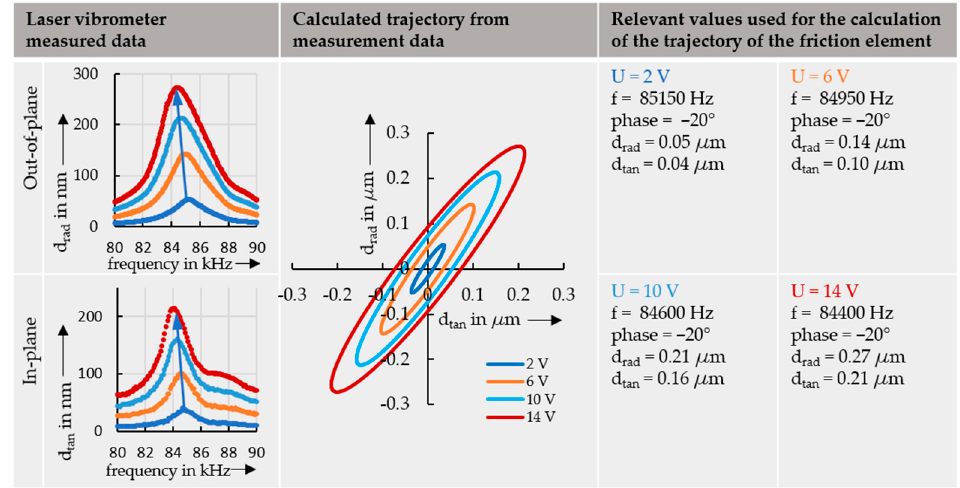
Figure 7. Measurements of radial and tangential displacement when excited half-sided ( left ); calculated trajectories ( right ).